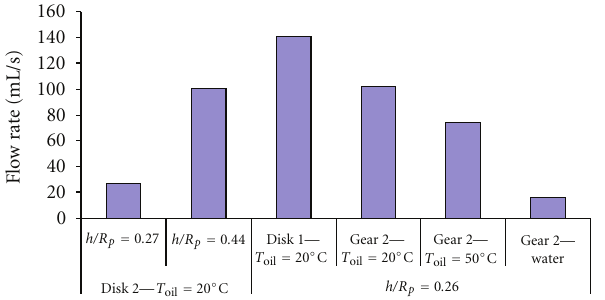
Figure 6: oil flow rates with a disk.